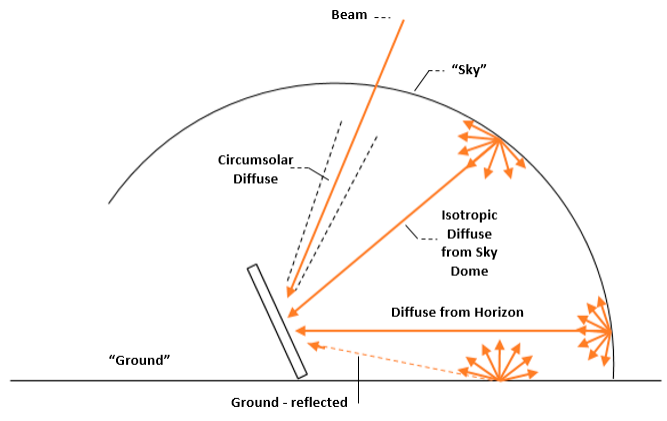
Figure 10. Solar radiation components on a tilted surface.